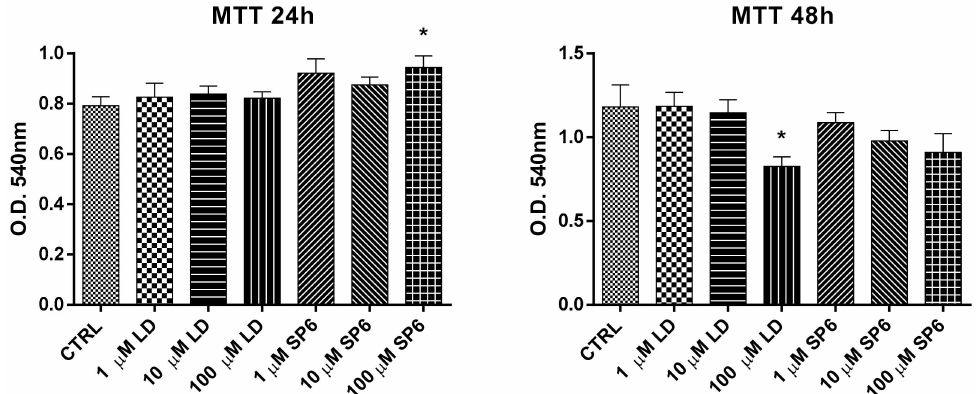
Figure 3. Dose-response e ff ects of LD and SP6 in di ff erentiated SH-SY5Y human neuroblastoma cells. MTT reduction assay in di ff erentiated SH-SY5Y human neuroblastoma cells in the presence of LD and SP6 . The cells were incubated for 24 or 48 h with increasing concentrations (1, 10, and 100 µ M) of